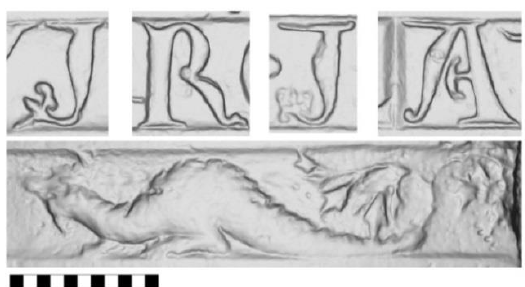
Figure 11. Medieval “Lettre Fleuries” and